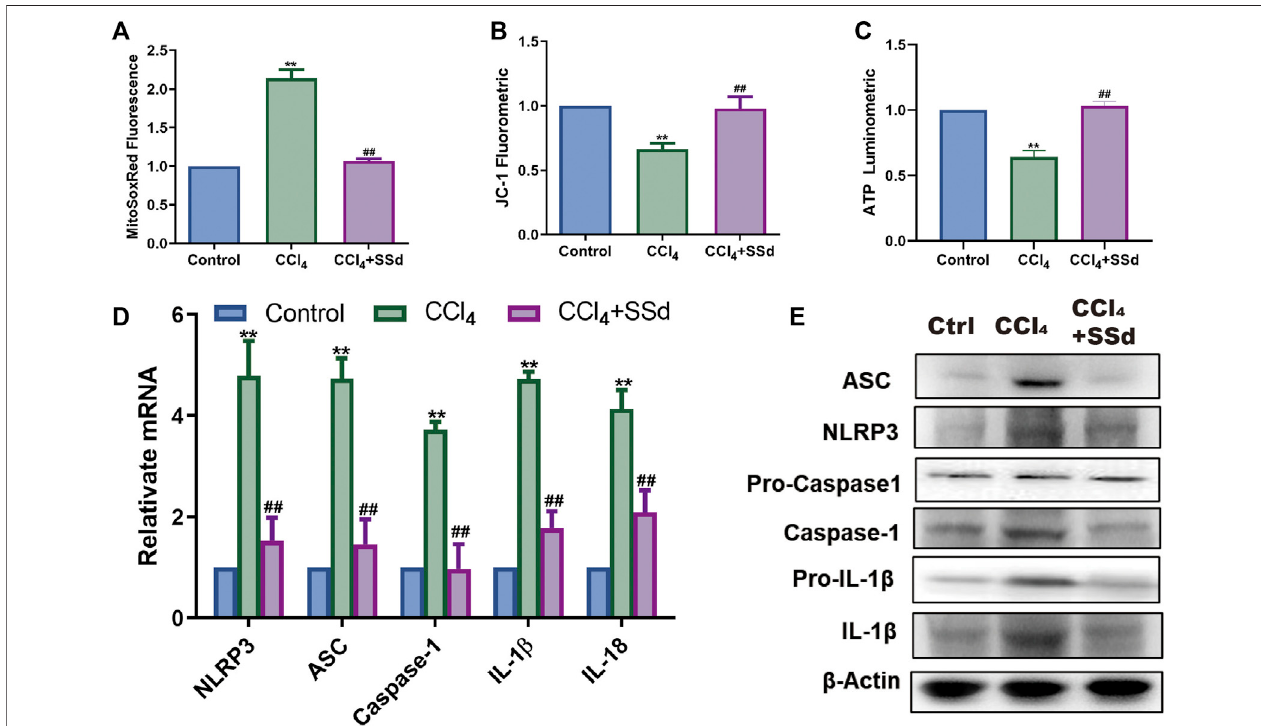
FIGURE2| SSdinhibitedmitochondrialdysfunctionsandNLRP3in fl ammasomeactivation. (A) MitoSOXRedMitochondrialSuperoxideIndicatordetection, n =6. (B) mitochondrialJC-1 fl uorescenceexpression, n =6. (C) ATPcontent, n =6. (D,E) relativemRNAandproteinsexpressionofin fl ammasome, n =3.Dataareexpressed in mean ± SEM; ** p < 0.01, CCL 4 group versus control group; ## p < 0.01, CCl 4 +SSd versus CCL 4 treated